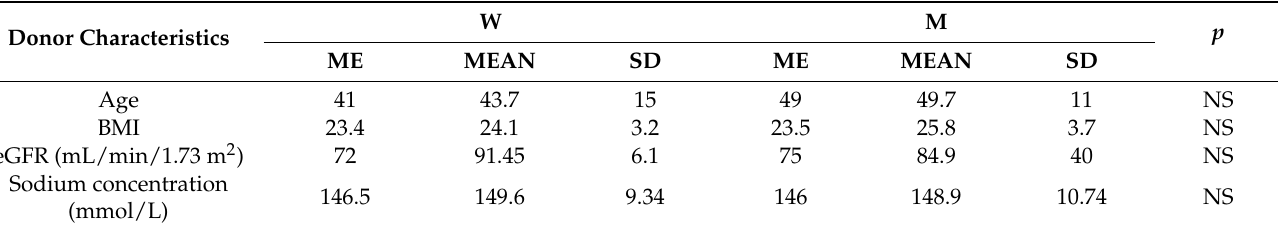
Table 3. Clinical kidney donor characteristics for both groups (male/female).